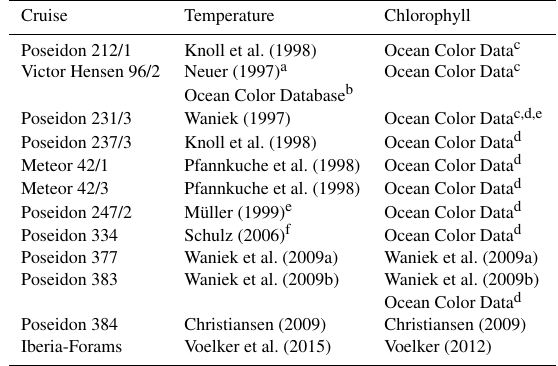
Table 2. Cruises with references for the temperature and chloro- phyll